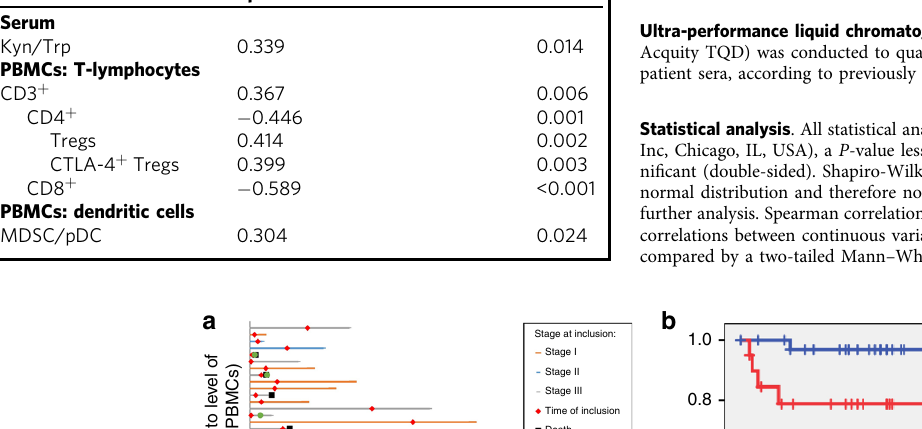
Table 1 Association of PD-L1 + CD8 + cells with other systemic immune markers Spearman correlation coef fi cient P -value